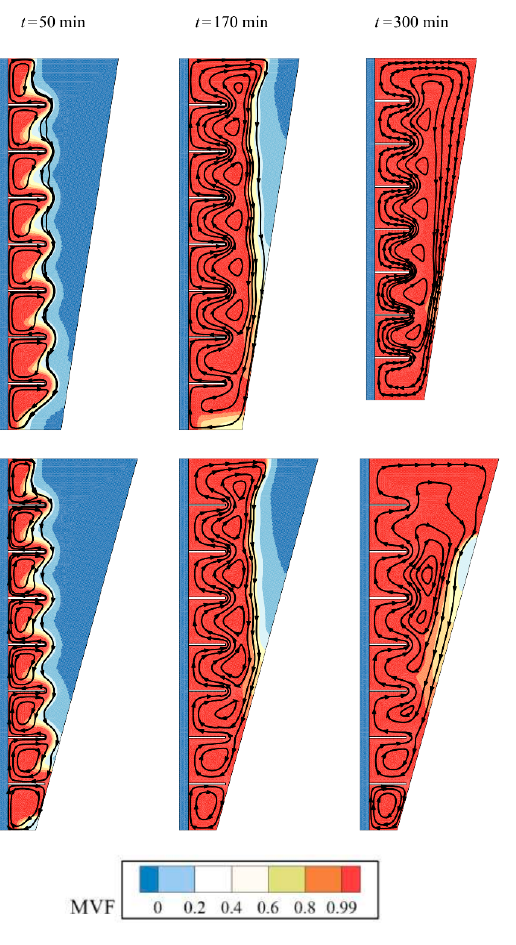
Figure 12. Effect of radius ratio ( AR ) on the stremlines, (Top row) Optimum case with AR = 0.675, and (bottom row) Case 9 with VF na = 0.04 for α = 0, and AR = 0.4.